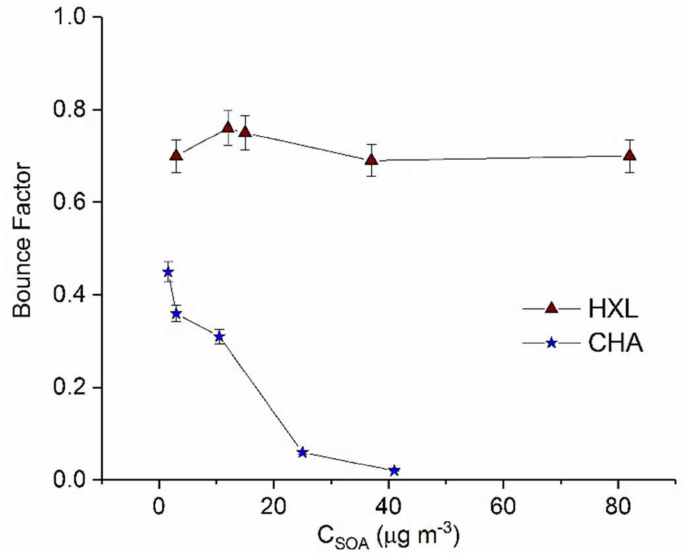
Figure 4. Calculated maximum BF for HXL ( cis -3-Hexen-1-ol) and CHA ( cis -3-Hexenyl Acetate) derived SOA as a function of C SOA . Error bars represent 1 standard